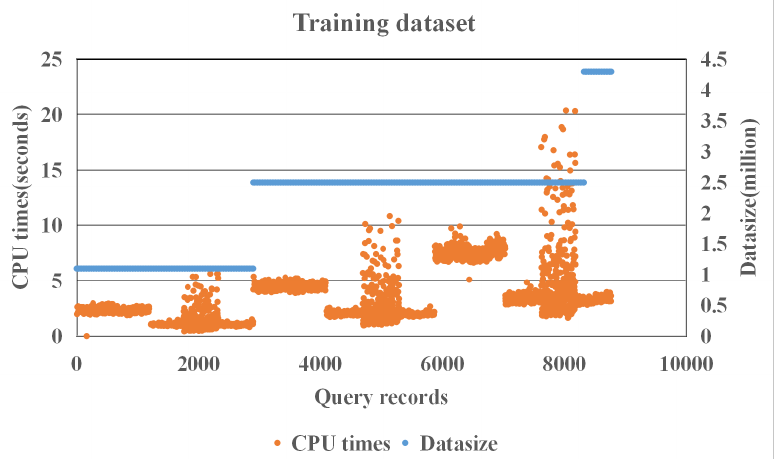
Figure 4. The CPU time distribution of training